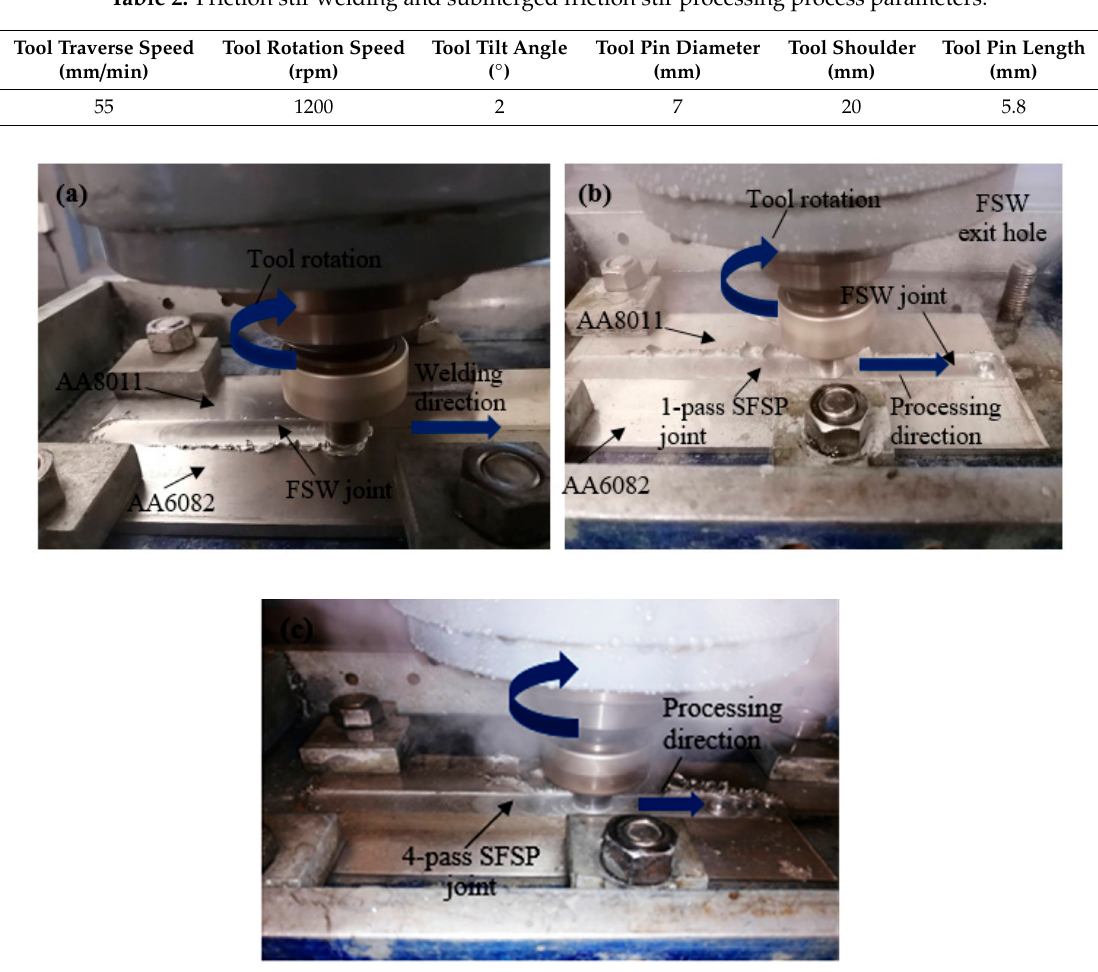
Table 2. Friction stir welding and submerged friction stir processing process parameters.